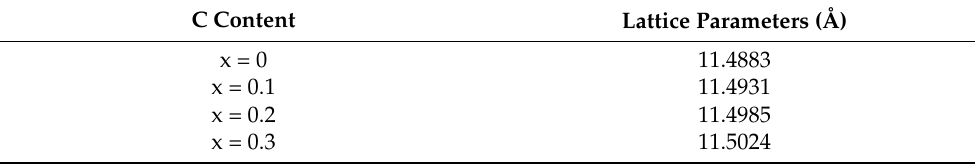
Figure 1. X-ray diffraction patterns of unannealed LaFe 11.5 Si 1.5 C x (x = 0, 0.1, 0.2, 0.3) ribbons at a surface speed of 35 m/s ( a ); calculated nucleation rates of the α -(Fe, Si) and La (Fe, Si) 13 phases versus under-cooling degrees at different C contents; ( b ) x = 0; ( c ) x = 0.2. Table 1. Lattice parameters of unannealed LaFe 11.5 Si 1.5 C x (x = 0, 0.1, 0.2, 0.3) ribbons.